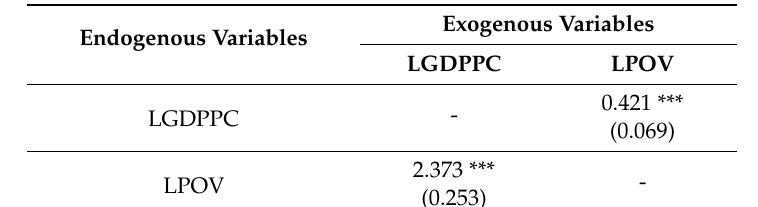
Table 3. Long-Run Elasticities.